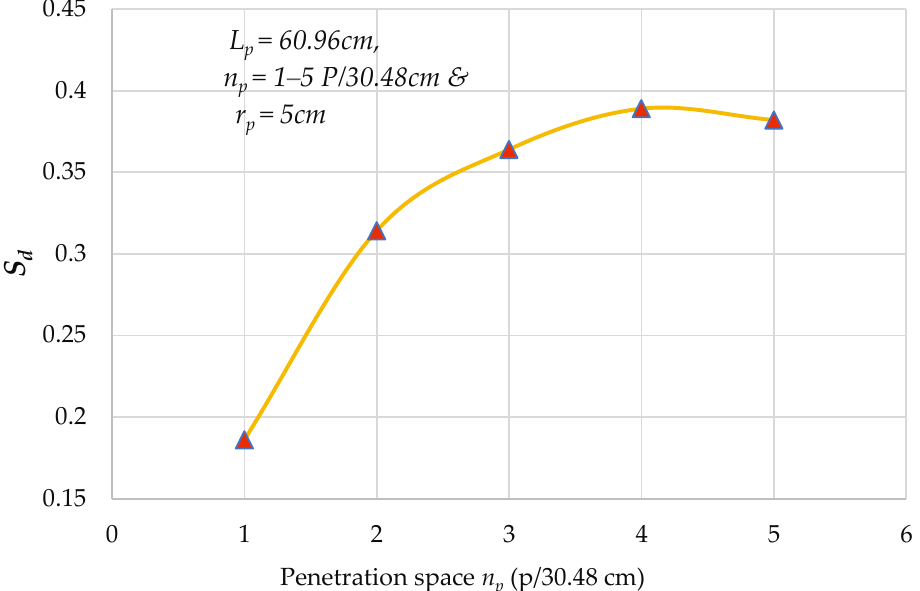
Figure 14. Difference in skin factor values for two perforation orientations with increasing penetration space n p (1–5 perforations/30.48 cm).